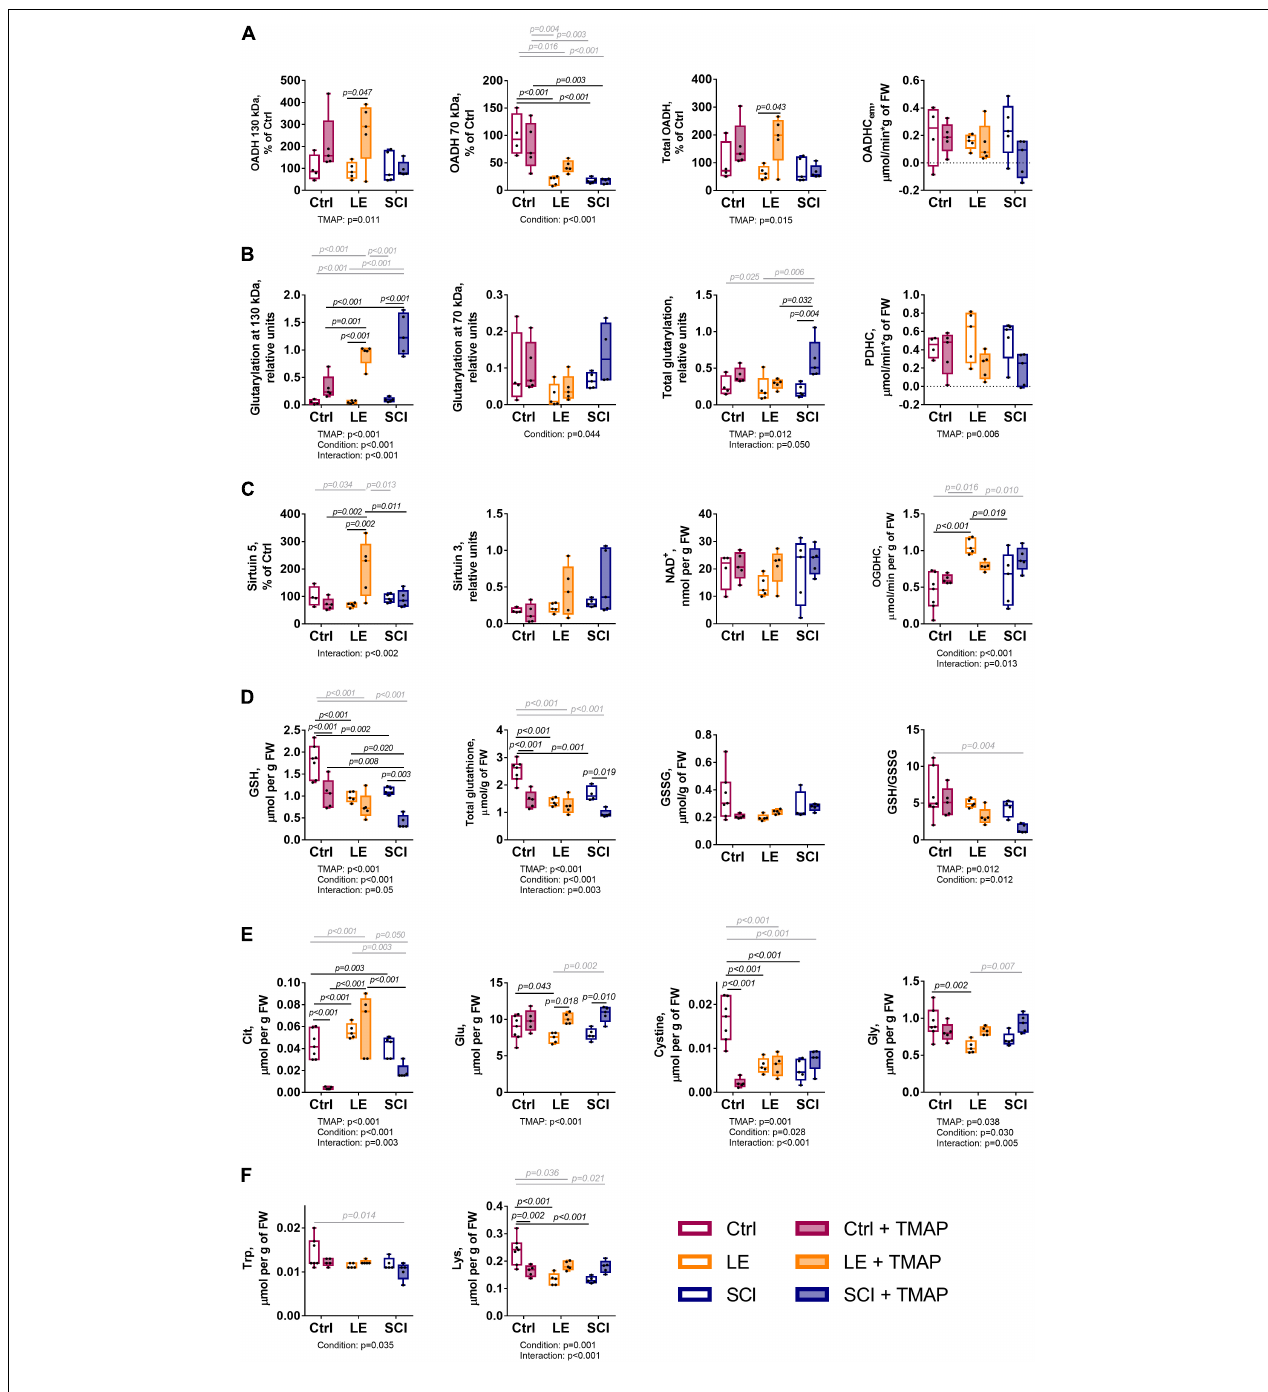
FIGURE 5 | Long-term changes in selected biochemical parameters of the cerebral cortex of the control, LE and SCI rats 8 weeks after a single administration of the OADH-directed inhibitor TMAP. Representative Western blots for relative glutarylation and protein levels are shown in Supplementary Figures 2–5 . (A) Relative expression of the OADH isoforms 130 and 70 kDa, total OADH and enzymatic activity of extramitochondrial OADHC. (B) Relative glutarylation of the brain proteins of 130 and 70 kDa, total glutarylated protein and PDHC activity. (C) Expression of sirtuin 5, sirtuin 3, level of NAD + and enzymatic activity of OGDHC. (D) Glutathione redox state homeostasis: levels of reduced glutathione (GSH), total glutathione, oxidized glutathione (GSSG), and the glutathione redox ratio. (E) Levels of metabolites involved in glutathione homeostasis: citrulline (Cit), cystine, glutamate (Glu), glycine (Gly). (F) Metabolic indicators of the OADH function: tryptophan (Trp) and lysine (Lys). Statistical significance of differences between experimental groups is determined by two-way ANOVA with Tukey’s post-hoc test. Factor significances and their interaction, estimated by ANOVA, are shown as p -values ( p < 0.05 only) below the graphs. The p -values on the graphs show the results of the post-hoc test, that are in black or gray for the experimental groups differing by one or two factors, correspondingly.